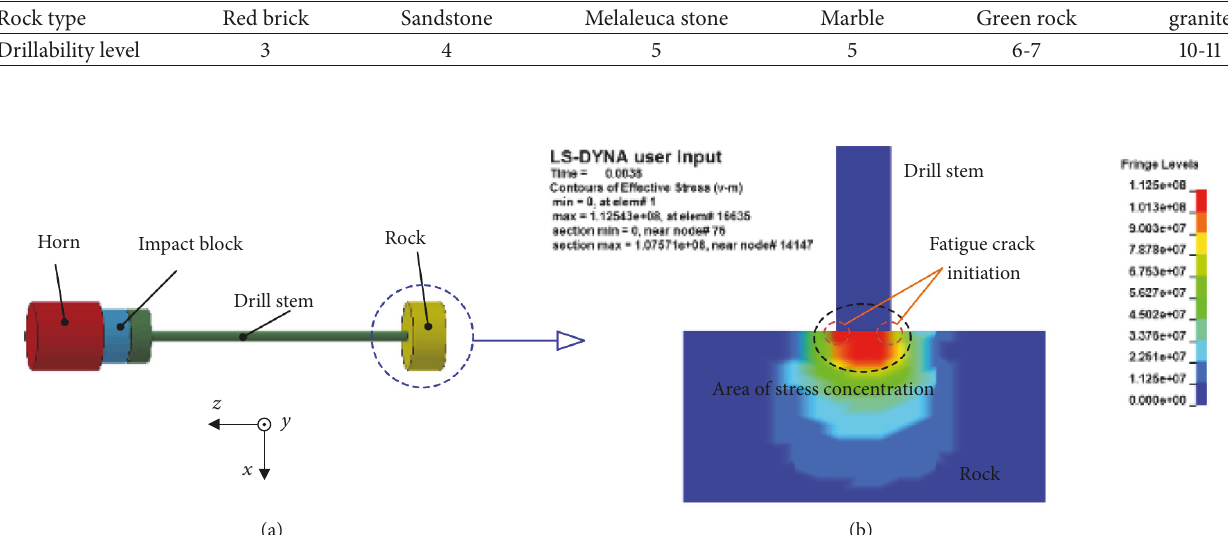
Figure 10: The LS-DYNA model and the simulation result. (a) LS-DYNA model. (b) Simulation result.